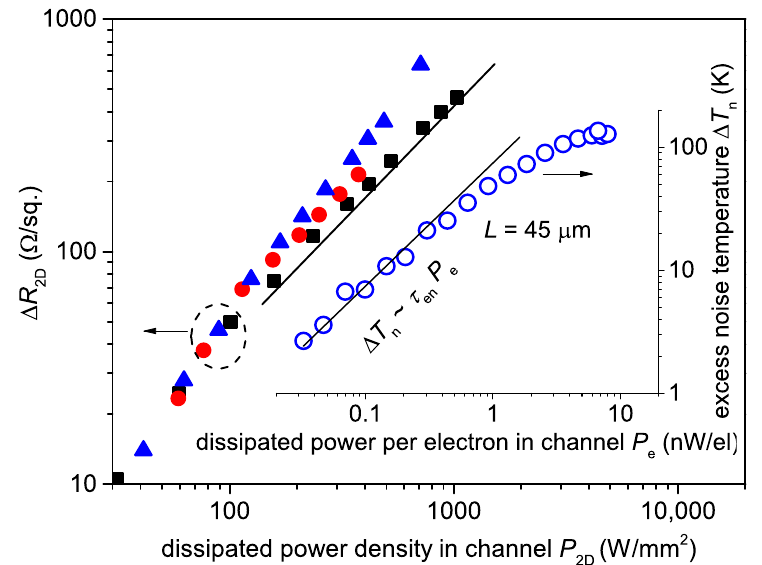
Figure 8. The dependence of channel resistance change ∆ R 2D = R 2D − R 2D0 on dissipated power density in channel; AlGaN/GaN (closed squares), AlGaN/AlN/GaN (closed triangles and circles). The inset shows the dependence of the excess noise temperature ∆ T n on the dissipated power per electron P e in the 45 µ m-long channel. The lines in the main panel and inset demonstrate the dependencies of ∆ R 2D ∼ P 2D and ∆ T n ∼ P e ,